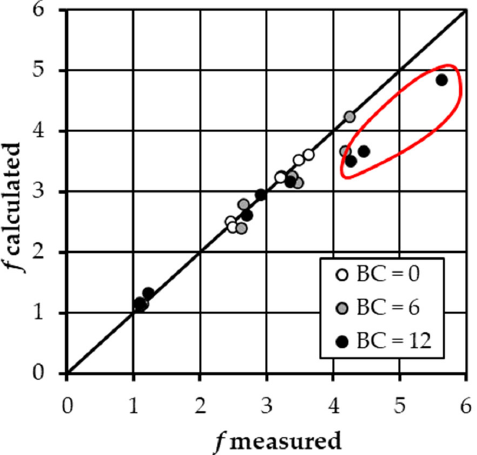
Figure 4. Comparison between the measured friction factor values, and the ones, f , calculated by Equation (11) with Γ v values estimated by Equation (10) with a = 0.0276, 0.0297, and 0.0311 for BC = 0, 6, and 12 kg m −2 , respectively. The red box includes experimental pairs with the highest BC value and the lowest X values.